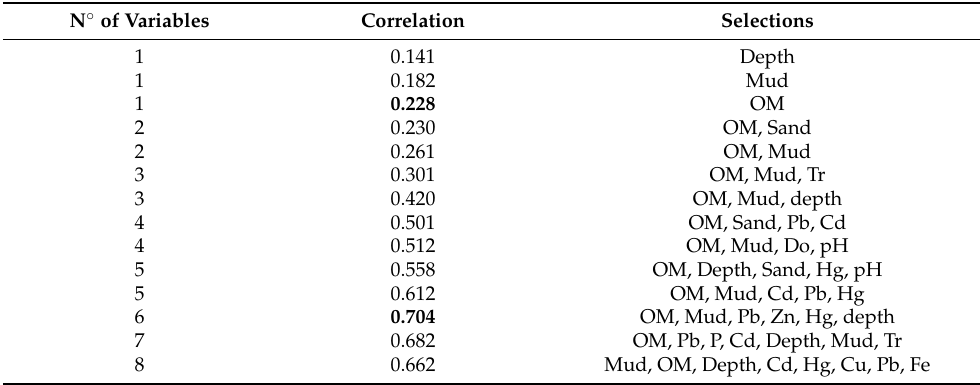
Table A3. Best correlations obtained between an increasing number of environmental variables and macrofaunal distribution in the three different harbours, as obtained from the BIO-ENV procedure. The maximum correlation (0.704) is obtained by associating six variables: OM: organic matter (highest individual correlation = 0.228); Do: dissolved oxygen; Tr: